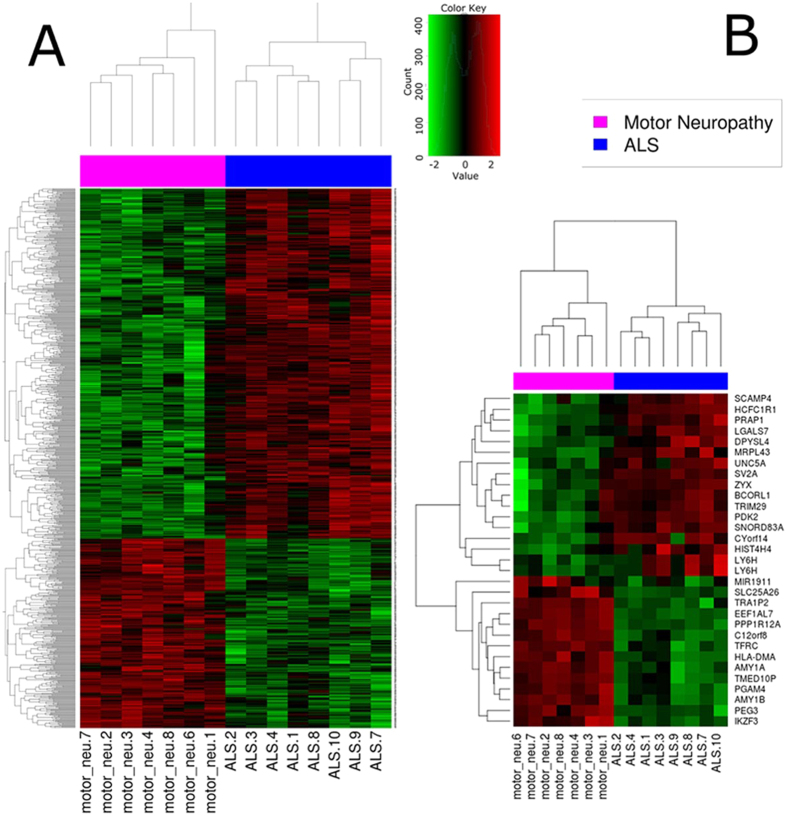
Heatmap representing hierarchical clustering of the 15 samples (columns) and genes (rows) detected as differentially expressed according to two different thresholds.(A) FDR < 0.01 and FC > 1.5 or FC < 0.66; (B) FDR < 0.05 and FC > 3 or FC < 0.33. The expression level of each gene has been standardized by subtracting the gene’s mean expression level and dividing by the standard deviation across all samples. This scaled expression value is plotted in red-green scale color, with red indicating higher expression and green lower expression in ALS patients.